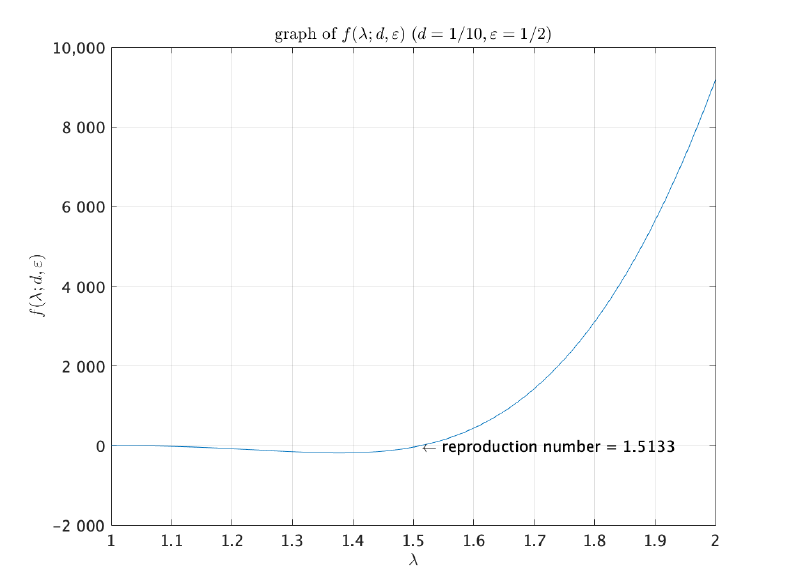
Figure 1. Graph of f ( λ ) with d = 1/10 and ε = 1/2. For fixed d , we have a map ( 0, 1 ) (cid:51) ε (cid:55)→ R 0 ∈ ( 1, 2 ) , and so Figure 2 exhibits the ε -dependence of the reproduction numbers R 0 ( ε ) for some d .